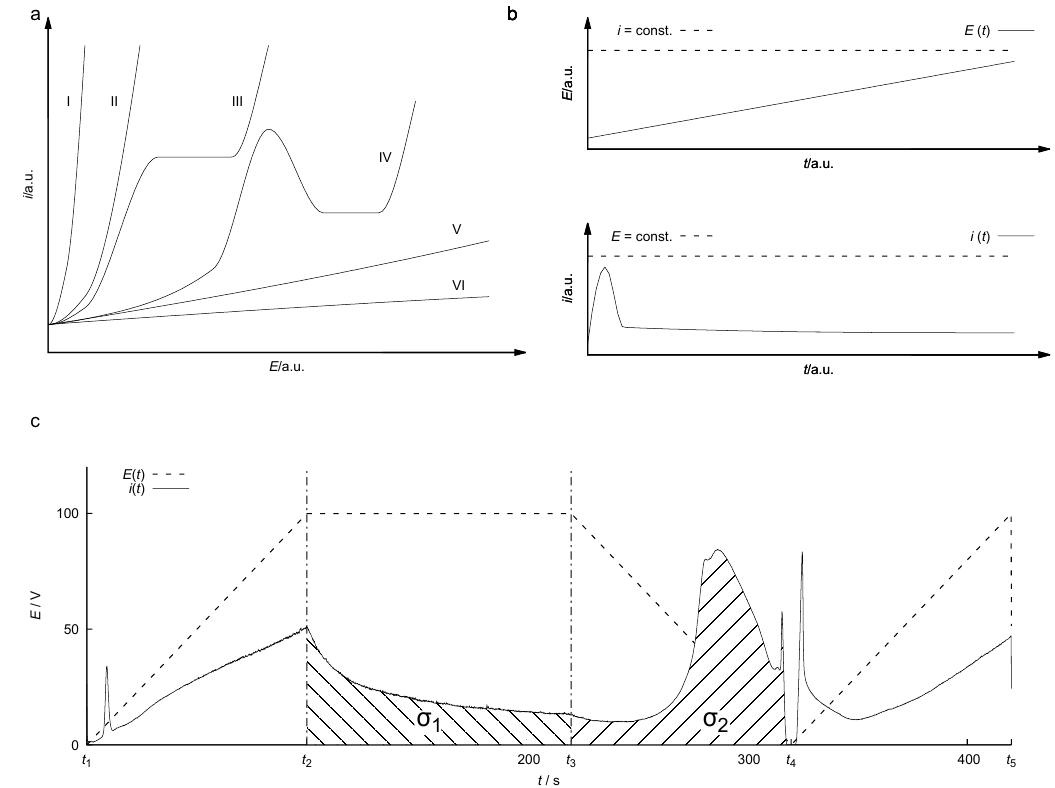
Figure 1. Comparative schematic representation of the results of qualitative polarisation [4,5] ( a ) and step measurements [6,7] ( b ) experiments as well as quantitative polarisation experiments ( c ) to determine the passivation capability of plasma electrolytic oxidation (PEO)